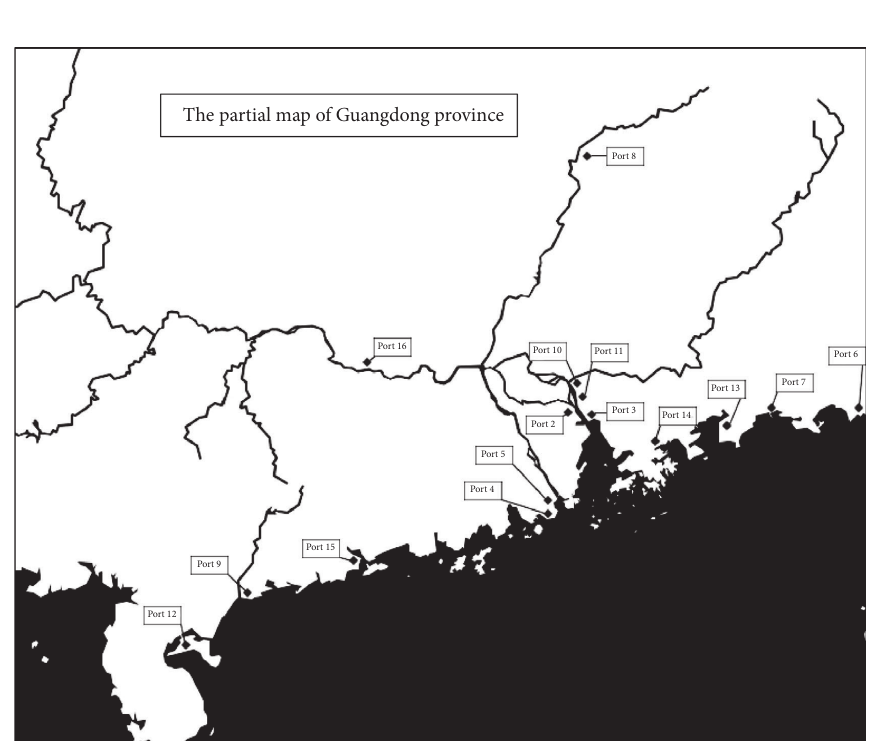
Figure 4: Geographical distribution of unloading